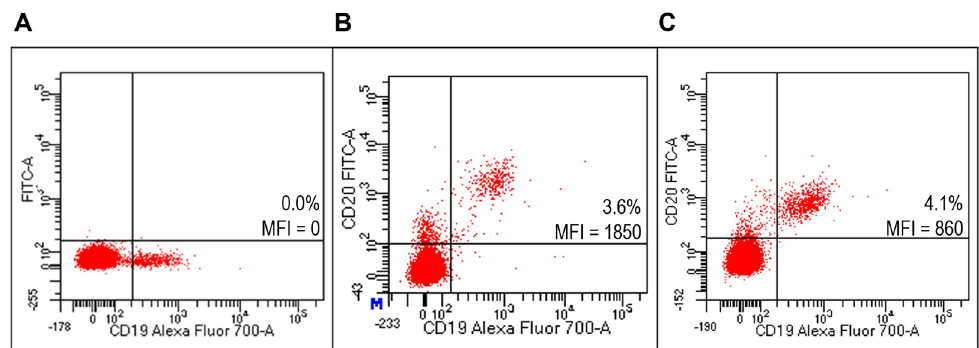
Figure 6. Evaluation of liposomes derivatized with FITC-Ritux Fab on HD PBMC. Representative FACS profiles indicating the MFI values of FITC-Ritux Fab labelled among HD PBMC. Cells were stained with the anti-CD19-Alexa Fluor700 ( A ) and FITC-Ritux Fab ( B ) or combination of liposomes functionalized with Ritux Fab /FITC-Ritux Fab (90/10 mol/mol) ( C ).